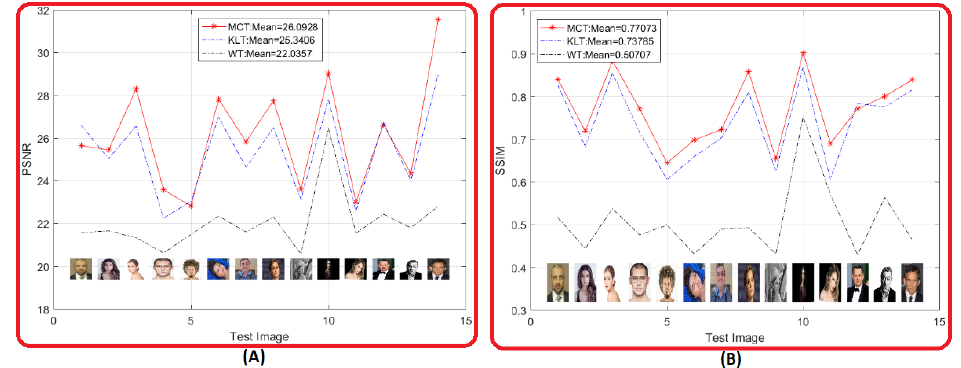
Figure 16. A metric comparative evaluation applied on 16 facial images of full face dataset of AR database. ( A ) PSNR and ( B ) SSIM.